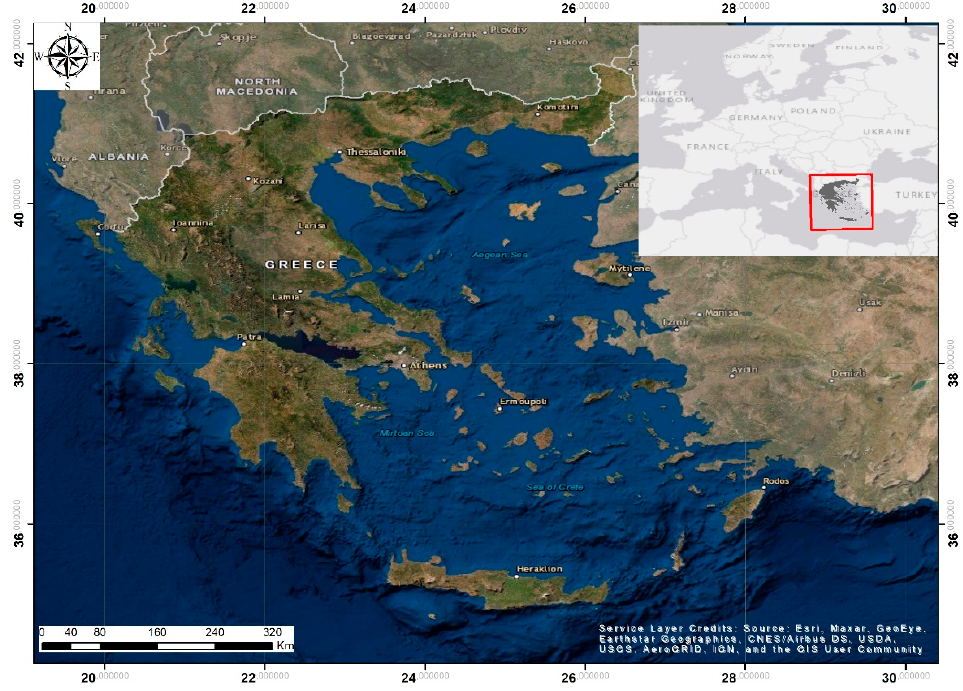
Figure 1. Location map of the study.